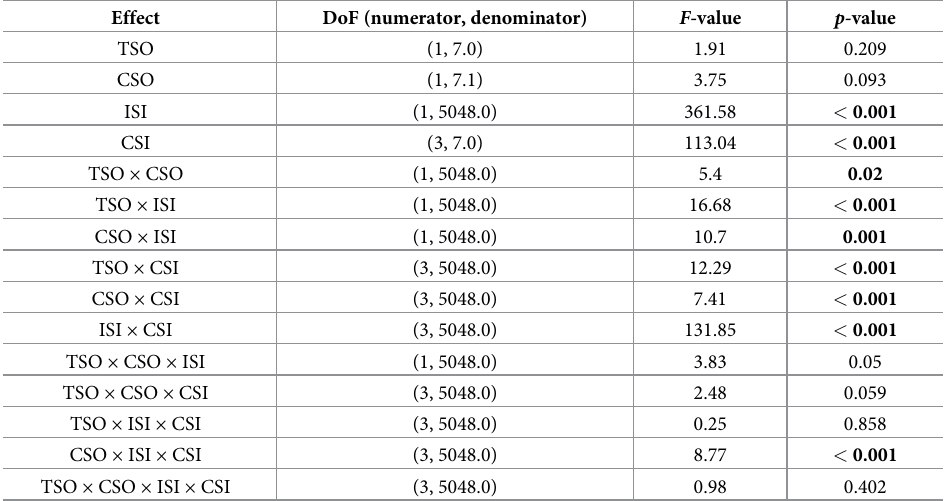
Table 2. Type-III analysis of variance table for the linear mixed-effects model analysis of the MEP amplitude.